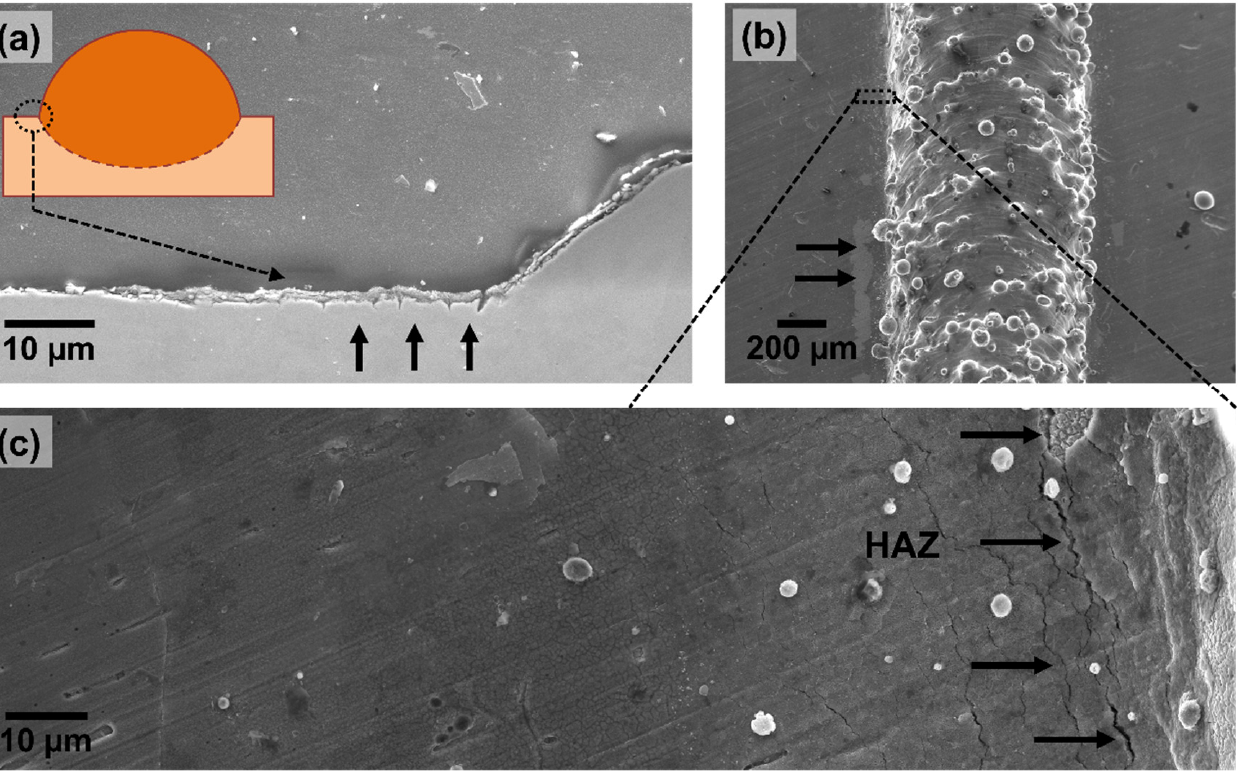
Figure 13. Images of samples after immersion in 3.5 wt.% NaCl at pH 2 for one week. Secondary electron images of ( a ) the cross section and ( b ) the top view of a printed clad. ( c ) High magnification of the region marked in ( b ) around the heat-affected zone.